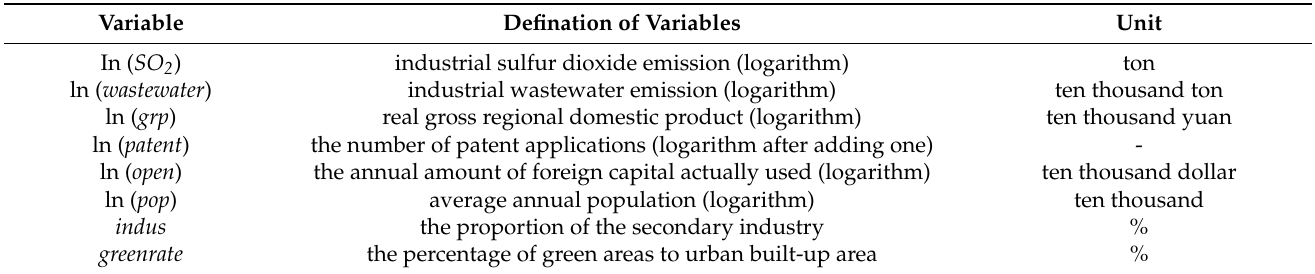
Table 2. Definition of variables.